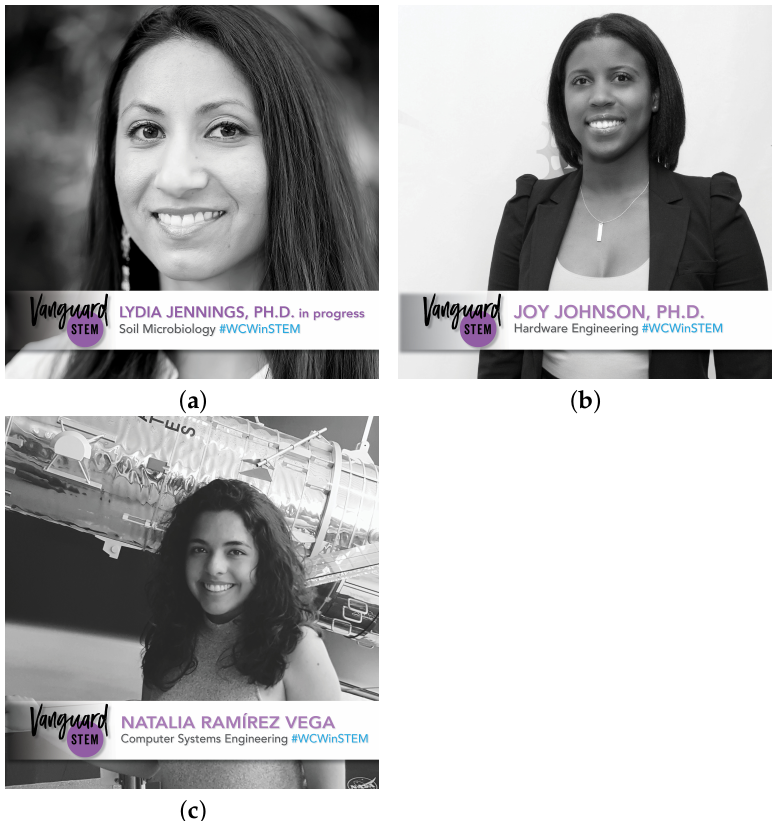
Figure 5. Above are three women of color in STEM (now-Dr. Lydia Jennings ( a ), Dr. Joy John- son ( b ) and Natalia Ramírez Vega ( c )), of the more than 100 “Woman-crush Wednesday in STEM” (#WCWinSTEM) features written and published by #VanguardSTEM over the last four years. These medium-length, science-driven features of women of color in STEM are often their first publicly available, in-depth articles about their STEM interests and